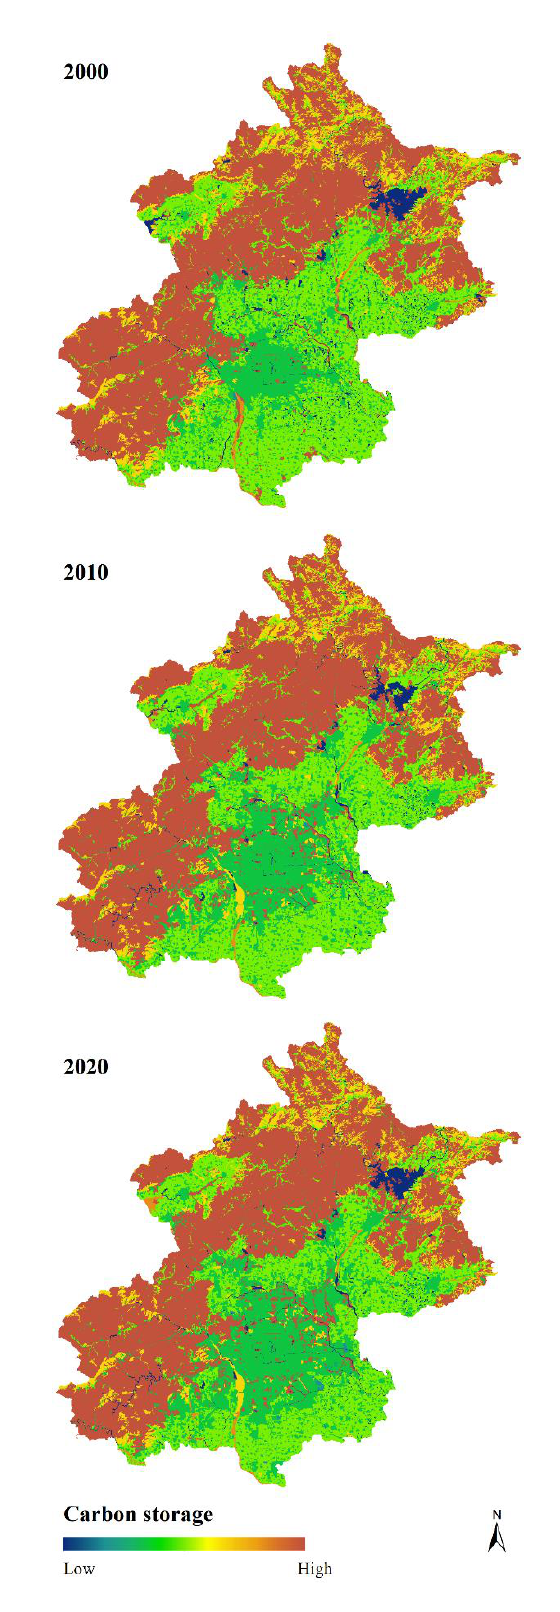
Figure 3 . Spatial distribution of carbon storage from 2000 to 2020 in Beijing.